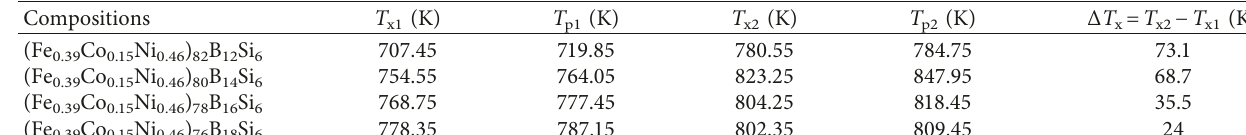
Figure 3: DSC curves of (Fe Table 1: Thermodynamic parameters of (Fe